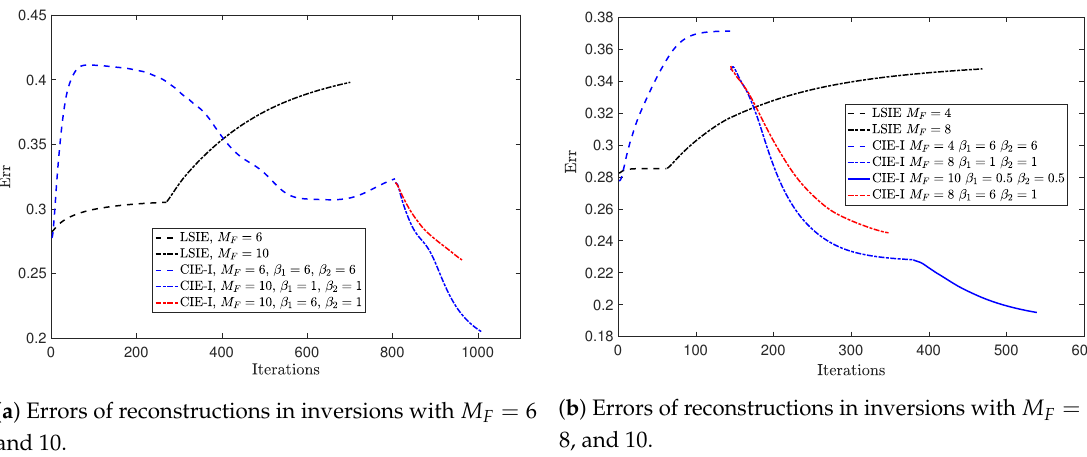
( b ) Errors of reconstructions in inversions with M F = 4, 8, and 10.